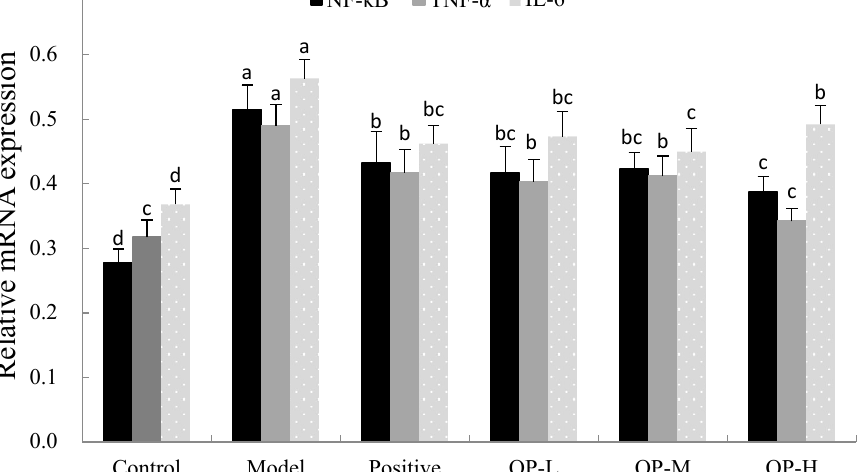
Figure 10. The mRNA expressions of NF- κ B, TNF- α , and IL-6 in liver of different groups (means ± SD, n = 10). Bars with different superscripts (a, b, c and d) were significantly different ( p < 0.01) according to ANOVA using the SPSS software and means were compared by Duncan’s multiple comparison post-test.